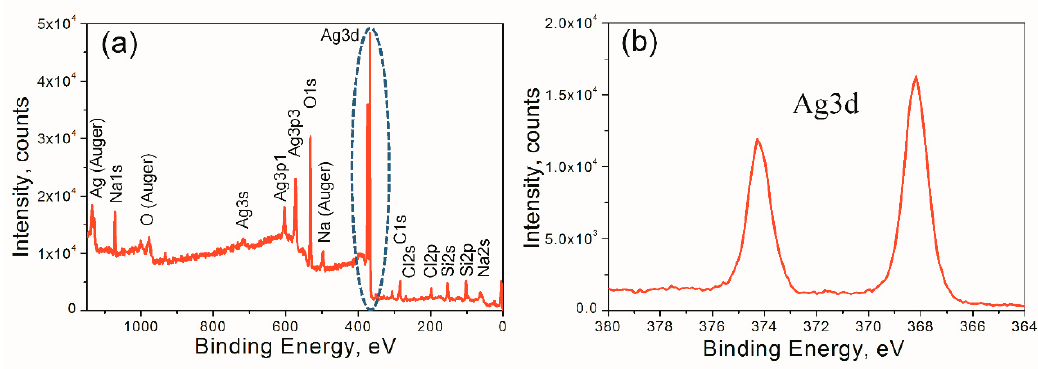
Figure 2. ( a ) XPS spectra of one sample of Ag NPs and ( b ) close-up image of Ag3d peaks.